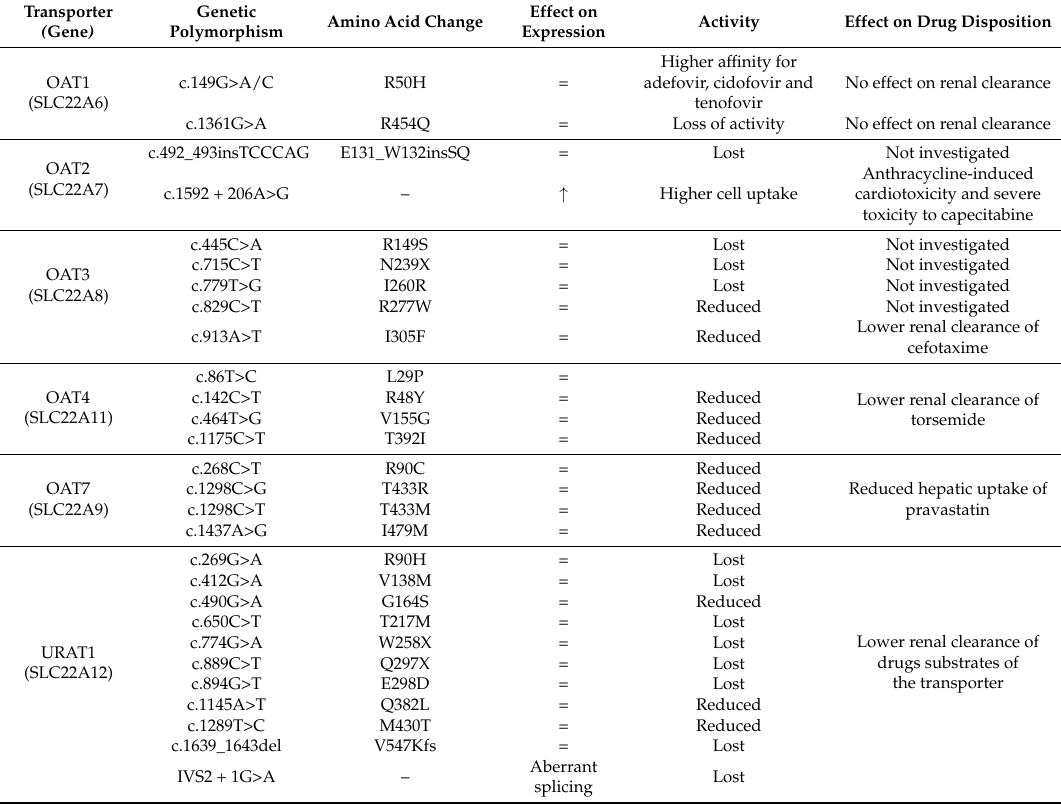
Table 4. Genetic variants in human organic anion transporters of the SLC22A